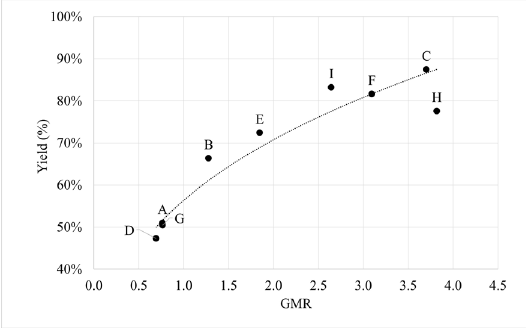
Figure 10. Yield in the range of 10-105 µm as a function of GMR.